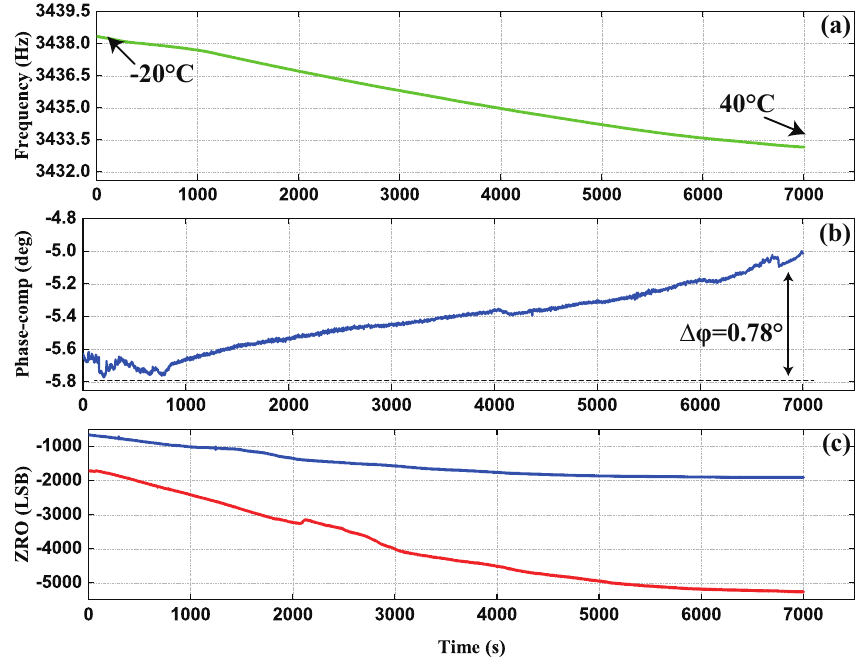
Figure 18. The ZRO of gyroscope at room temperature before and after compensation. ( a ) The driving frequency. ( b ) The variation of the compensation phase. ( c ) The ZRO before and after